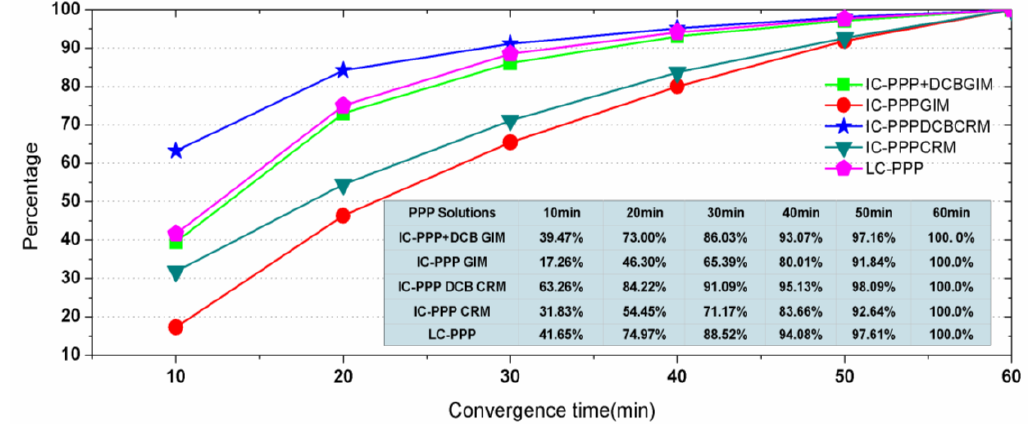
Figure 11. Success rates of convergence into 10 cm in horizontal components of the five PPP schemes.